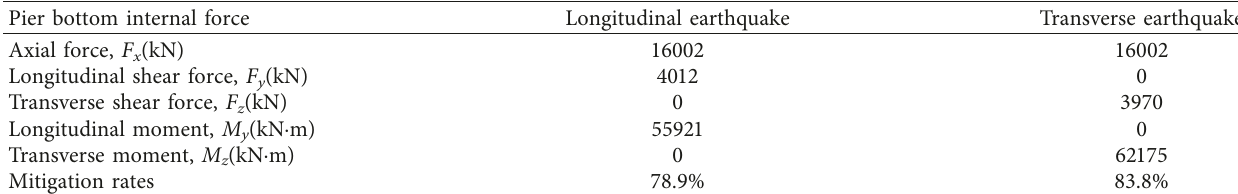
Table 6: Pier bottom internal forces with isolation devices under high-level earthquake.